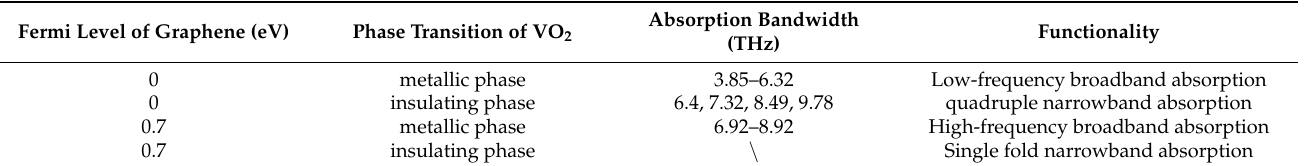
Table 1. Graphene and VO 2 correspond to the broadband and narrow band performance parameters of the absorber under different